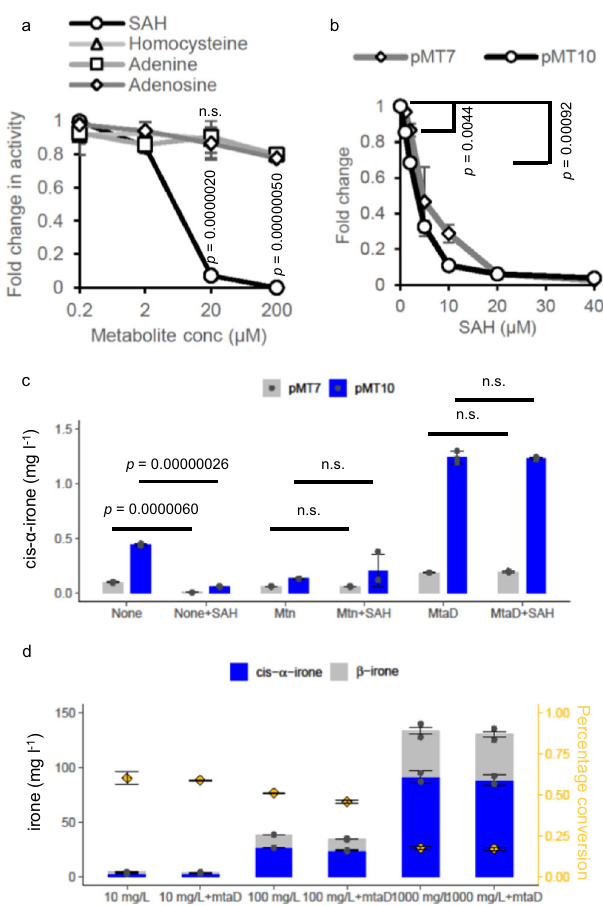
Fig. 3 | Kinetic characterization of pMT7 and pMT10 enzymes. a Fold change in pMT7 activity when SAH (0-200 μ M), homocysteine (0-200 μ M), adenine (0 – 200 μ M), or adenosine (0 – 200 μ M) was supplemented into puri fi ed pMT7 reaction. It was calculated by dividing the pMT7 activity where no additive was added. b Fold change in pMT7 and pMT10 activities when SAH (0 – 40 μ M) was supplemented intothepuri fi ed enzyme reactions.Itwas calculated bydividingthe pMT7 and pMT10 activity where no additive was added. c Effect of introducing auxiliary enzymes, Mtn and MtaD, to hydrolyse SAH on cis- α -irone production by purifying pMT7 and pMT10 with or without initial 20 μ M SAH. pMT10 increased production of cis- α -irone by ~4.5 and ~6.5-fold without and with MtaD enzyme, respectivelycomparedtopMT7reactionalone. a to c ,Theaverageands.d.ofthree biologically independent experiments are shown. Signi fi cance ( p -value) was eval- uated by a two-sided Student ’ s t -test, n.s. represents p >0.05. d In vitro bio- transformation of psi-ionone to cis- α -irone by using cell lysates containing overexpressed pMT10. The bar chart represents the mean value of irone con- centration. The orange diamonds represent the percentage conversion calculated based on the starting substrate concentration. The average and the s.d. of two biologically independent experiments are shown in the graph. The abbreviations are as follows. Mtn, S -adenosylhomocysteine nucleosidase. MtaD, S -adenosylho- mocysteinedeaminase.SAH, S